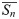
Average 2nd rank acyl chain order parameters (Sn).A) Average order parameter of the mutated lipid (DSPC→DOPC) in (top) the system containing A2AR, and (bottom) the protein-free system. The cholesterol content was 20 mol% in all systems. The Lo→Ld transformation takes place as the coupling parameter λ changes from zero to one. In Section B.1 in the S1 File, we demonstrate that these end points indeed correspond to the Lo and Ld phases. Error bars showing standard error are smaller than the marker size. B) Effects of SDPE and A2AR on average 2nd rank acyl chain order parameters (Sn¯). Data are shown for both coarse-grained and all-atom (fine-grained) simulations. For the latter, the order parameter is estimated from the average deuterium order parameter as Sn¯=-2SCD¯, and the error bars show the standard error.